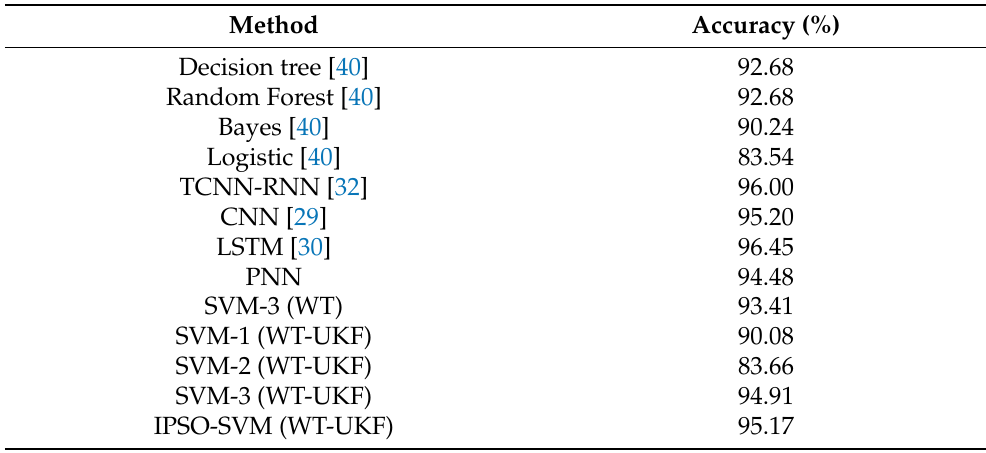
Table 5. Accuracy comparison of different algorithms (30 sample categories).